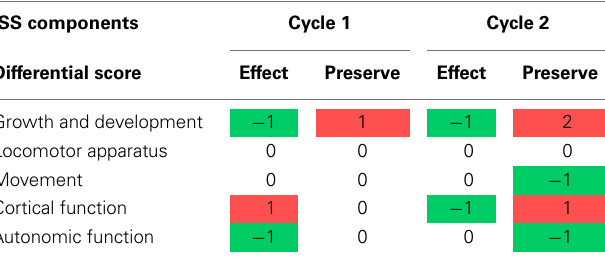
Table 6 | Differential scores of ISS scores during cycles .